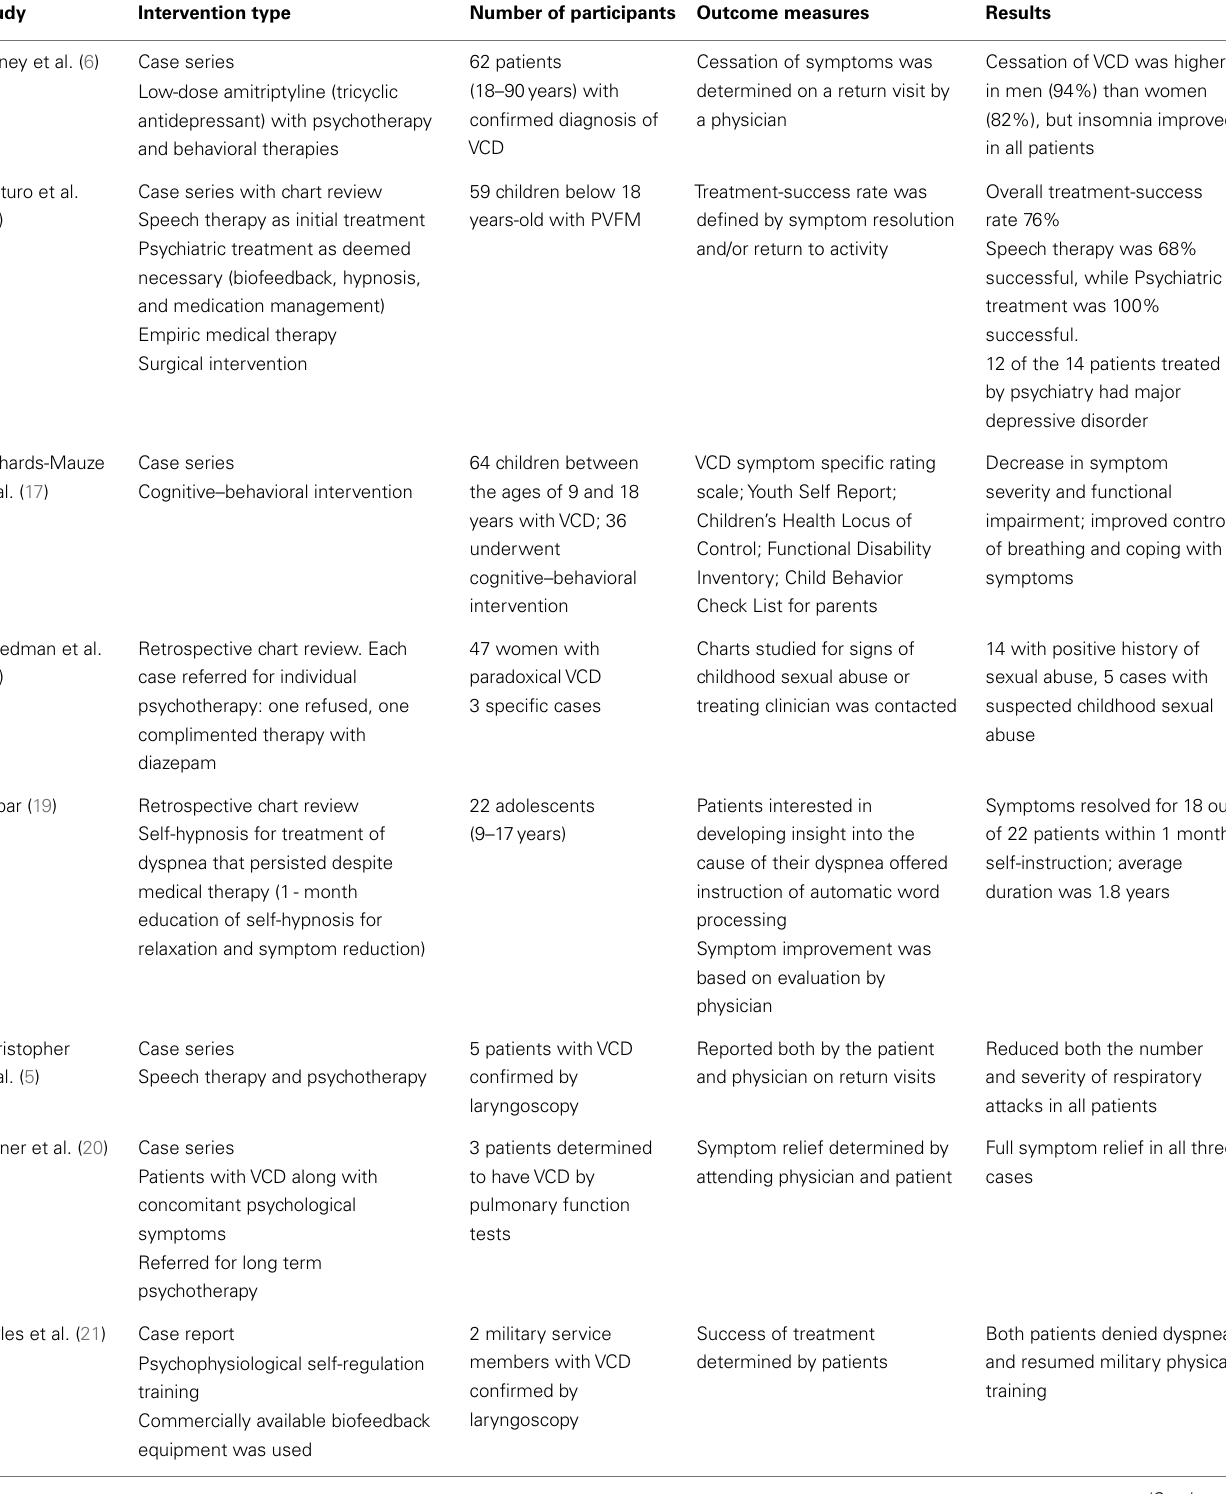
Table 1 | List of studies that have reported the use of various psychological interventions for patients withVCD/PVFM